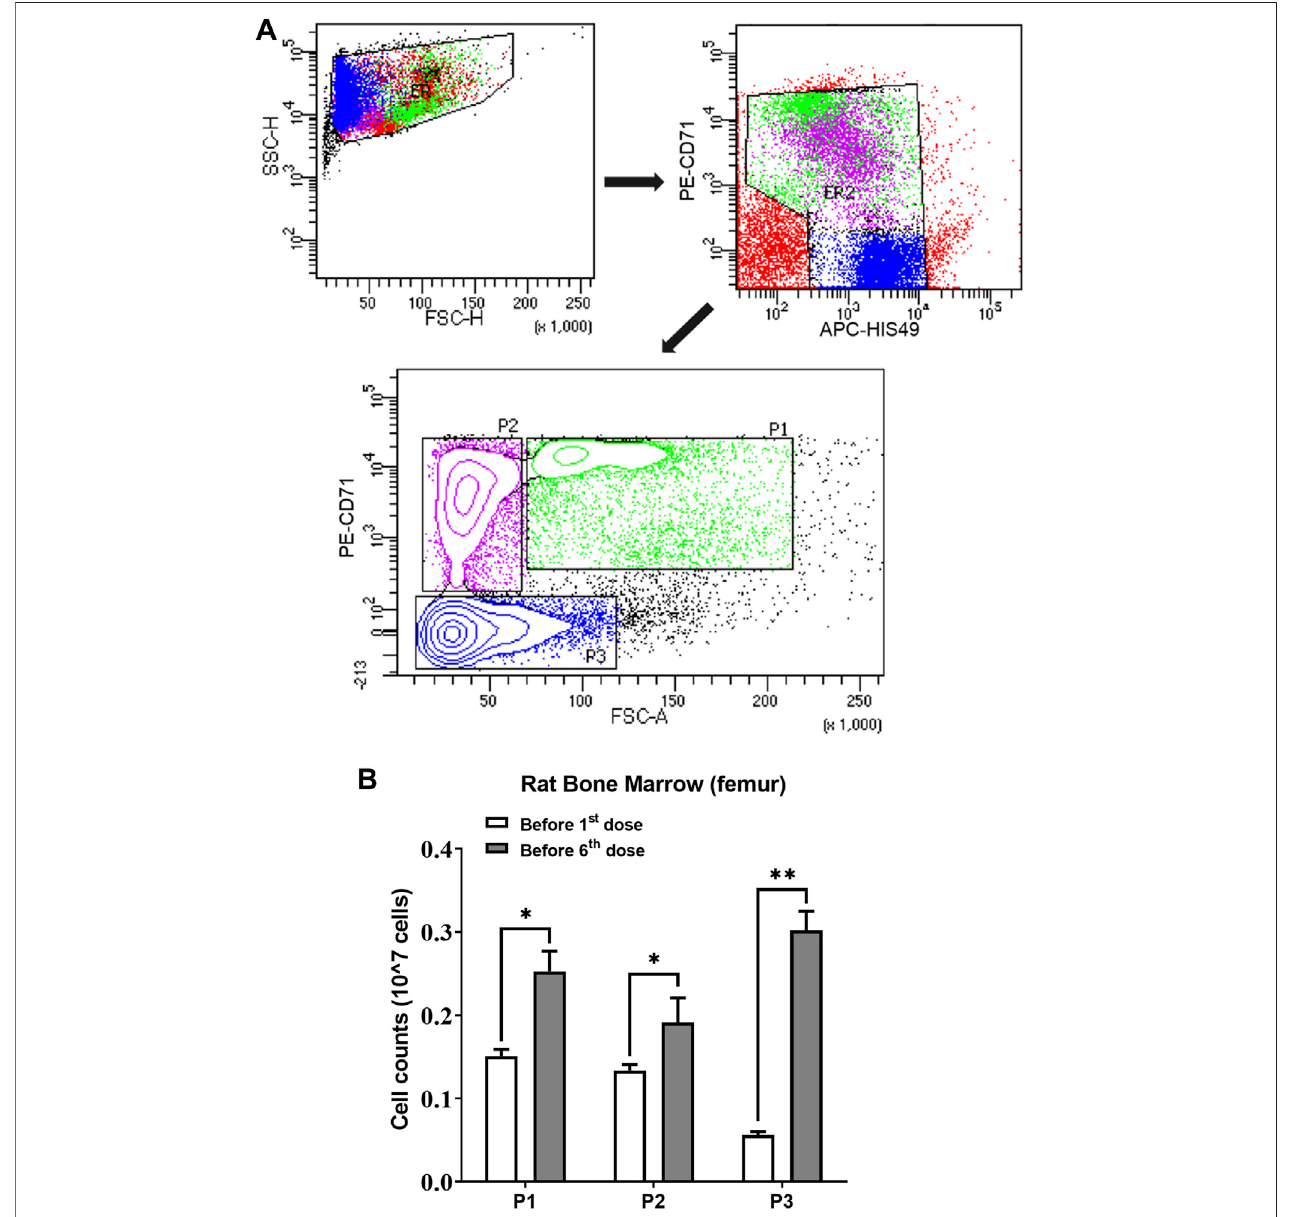
FIGURE 4 | (A) Gating strategy of the fl ow cytometry to sort and quantify erythroid precursors. (B) Three subpopulations of erythroid cells in bone marrow quanti fi edusing fl owcytometricanalysisbeforethe fi rstandsixthrHuEPOdose(450 IU/kg; n =3ineachgroup;* p < 0.05,** p < 0.001).P1,amixtureofproerythroblasts and basophilic,polychromaticand orthochromaticerythroblasts;P2,orthochromaticerythroblasts;P3,reticulocytes andmature redblood cells.Thesubpopulation cell counts were calculated by percentage × the total number of living cells in one femur.